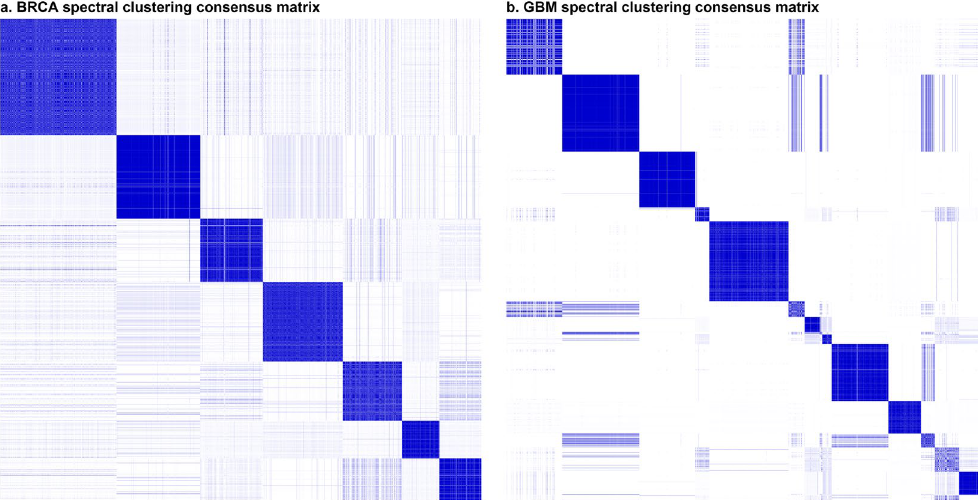
Figure 2. The consensus matrices of spectral clustering for identifying DEG modules. Spectral clustering was generated with 100 independent repeats of runs. The higher the frequency two DEGs were clustered into the same module, the darker blue the corresponding spot on the matrix. Each block sitting on the diagonal corresponds to a DEG module. The low overlapping across blocks indicates that spectral clustering was able to identify robust